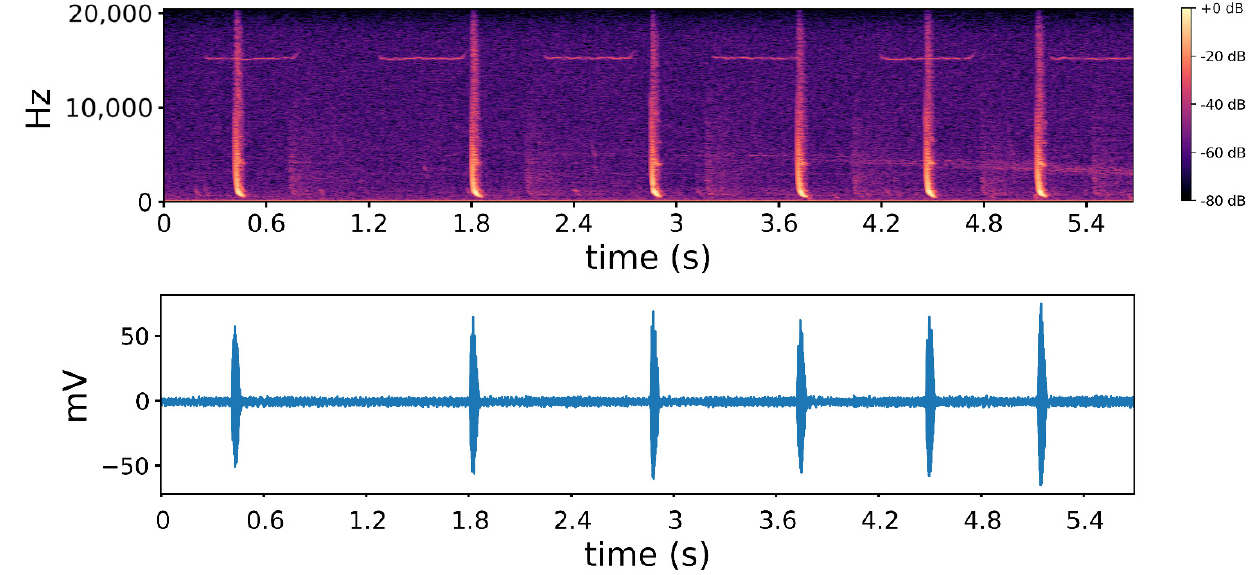
Figure 1. Time domain and T − F domain representation of an audio recording from Weddell seal.